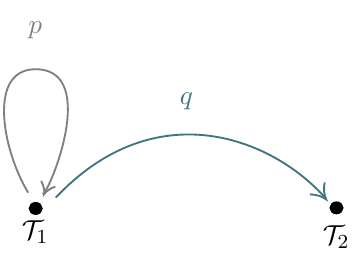
Figure 1 . Galois conjugation of TQFT T 1 by elements p, q in the Galois group. T 1 is invariant under Galois action by p , but it transforms non-trivially to T